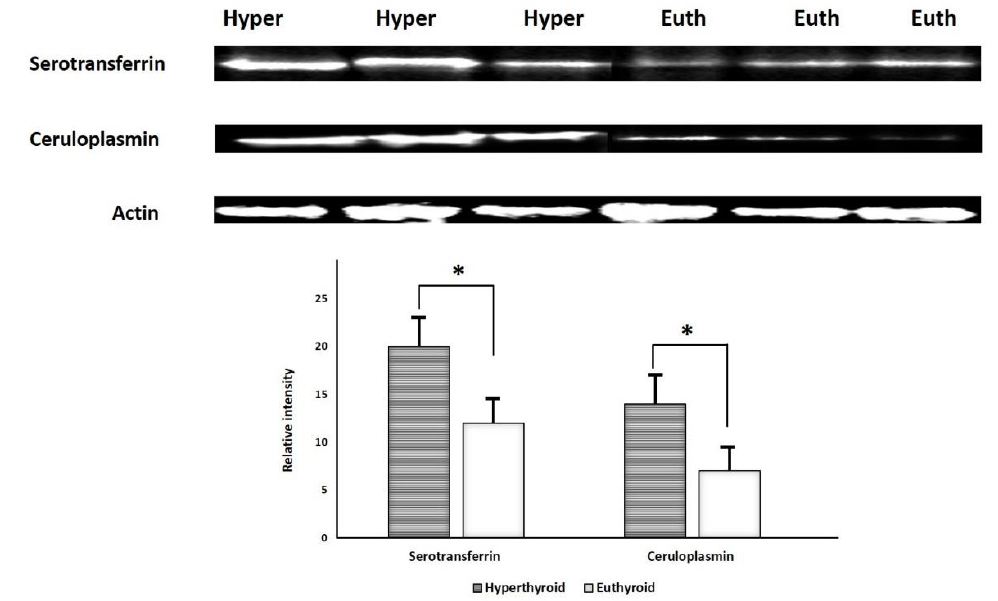
Figure 6. Immunoblot analysis of selected proteins identified by 2D-DIGE analysis was used to validate the proteomic results. The findings of immunoblotting were similar to the results of 2D-DIGE ( A ). Graphical representation of the relative intensity values of normalized protein bands between the hyperthyroid and euthyroid states. The data are reported as histograms of the mean ± SD ( B ). The * indicates p < 0.05.